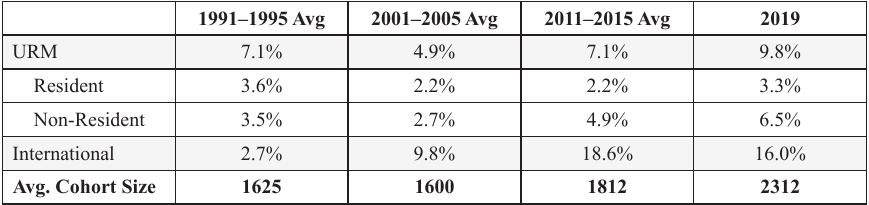
Table 1. Comparison of three decades of underrepresented minority and international students